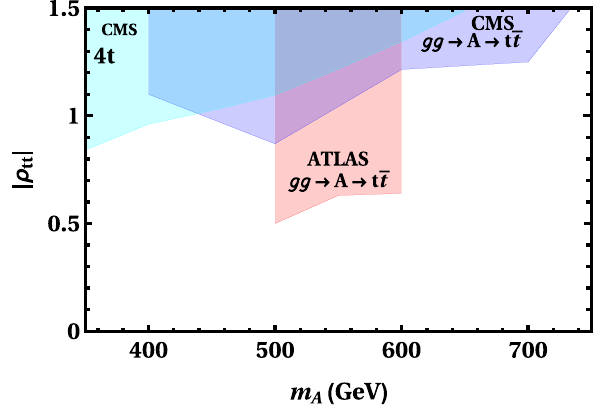
Fig. 6 Regions excluded from gg → H / A → t ¯ t searches by ATLAS [71] and CMS [72] are shown in red and blue shaded regions respec- tively. The cyan shaded regions are excluded by CMS [73] search for heavy H / A production in association with t quarks with H / A → t ¯ t